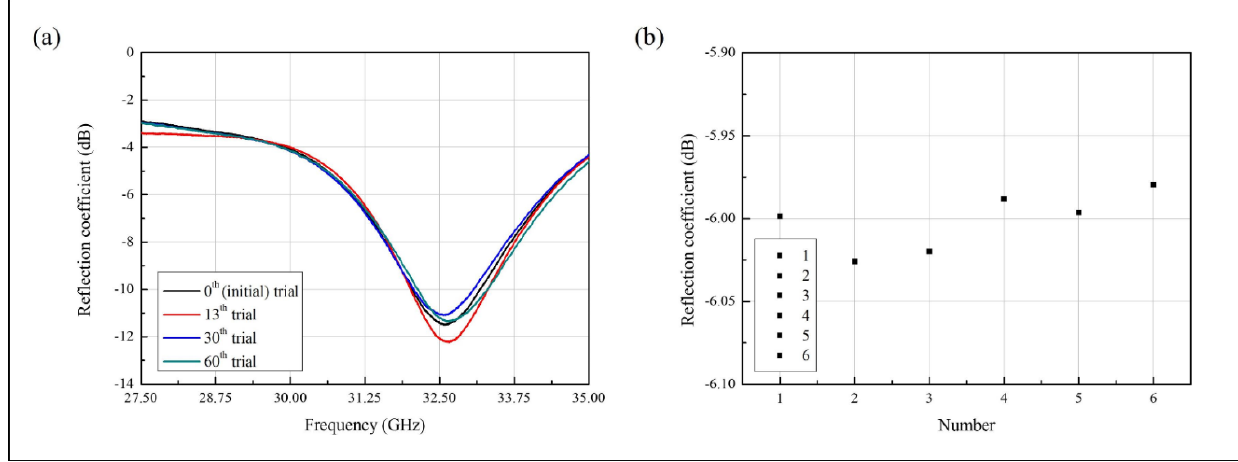
Figure 6. Measured reflection coefficients to investigate ( a ) the reusability and ( b ) the reproducibility of the sensor.